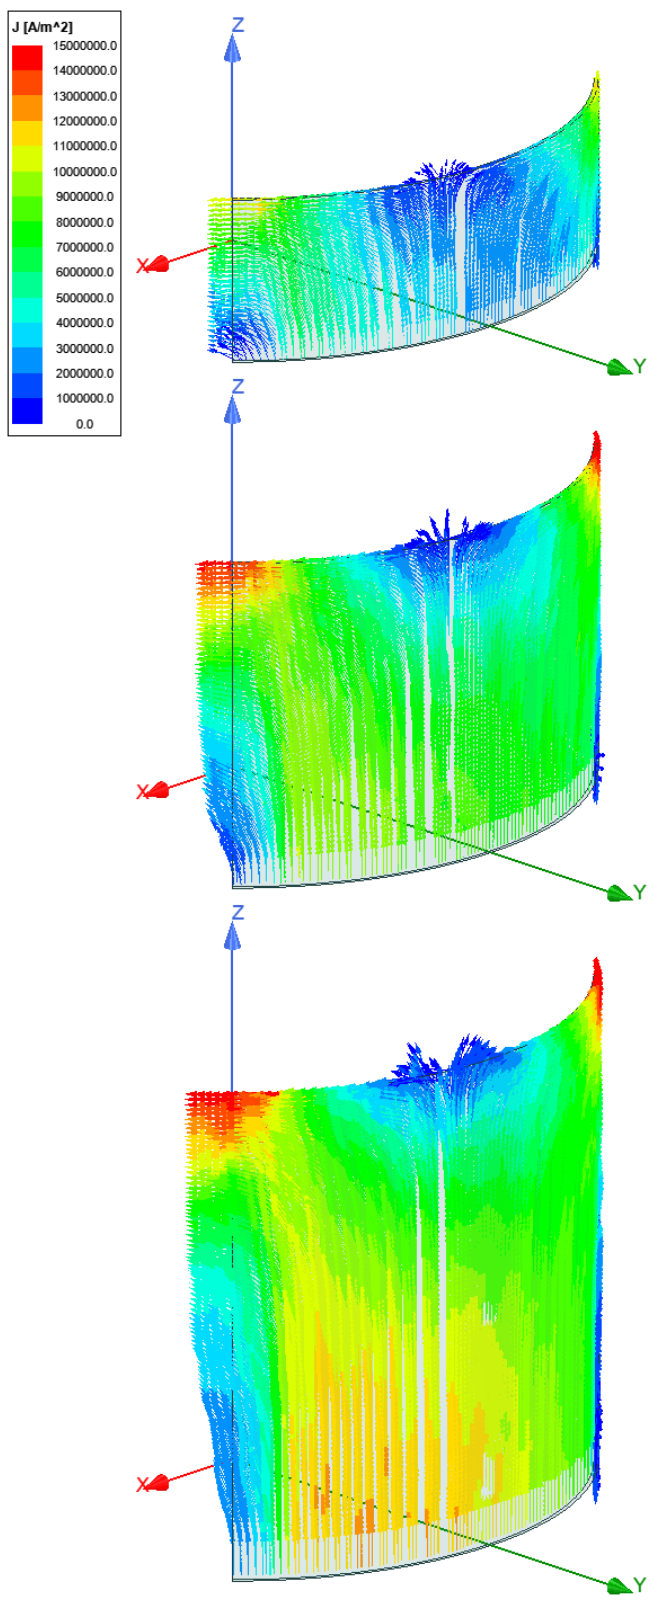
Figure 7. The distribution of J ec in the sleeve in AED at 4000rpm for three different values of l sl